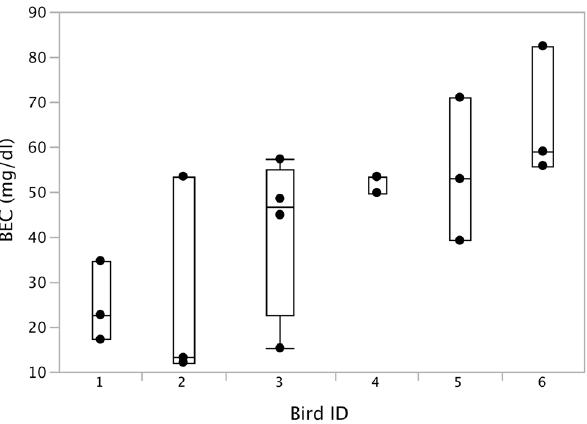
Fig. 2. Blood ethanol concentrations (BEC) in male zebra finches. Birds were provided with 6.5% alcohol in 50% juice during Phase III of our experimental